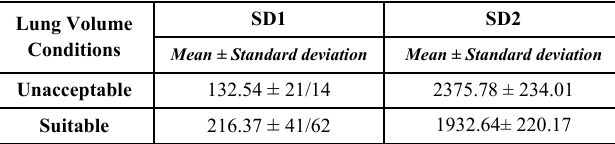
TABLE 4: The average and the standard deviation of the SD 1 and SD 2 parameters with τ = 4.